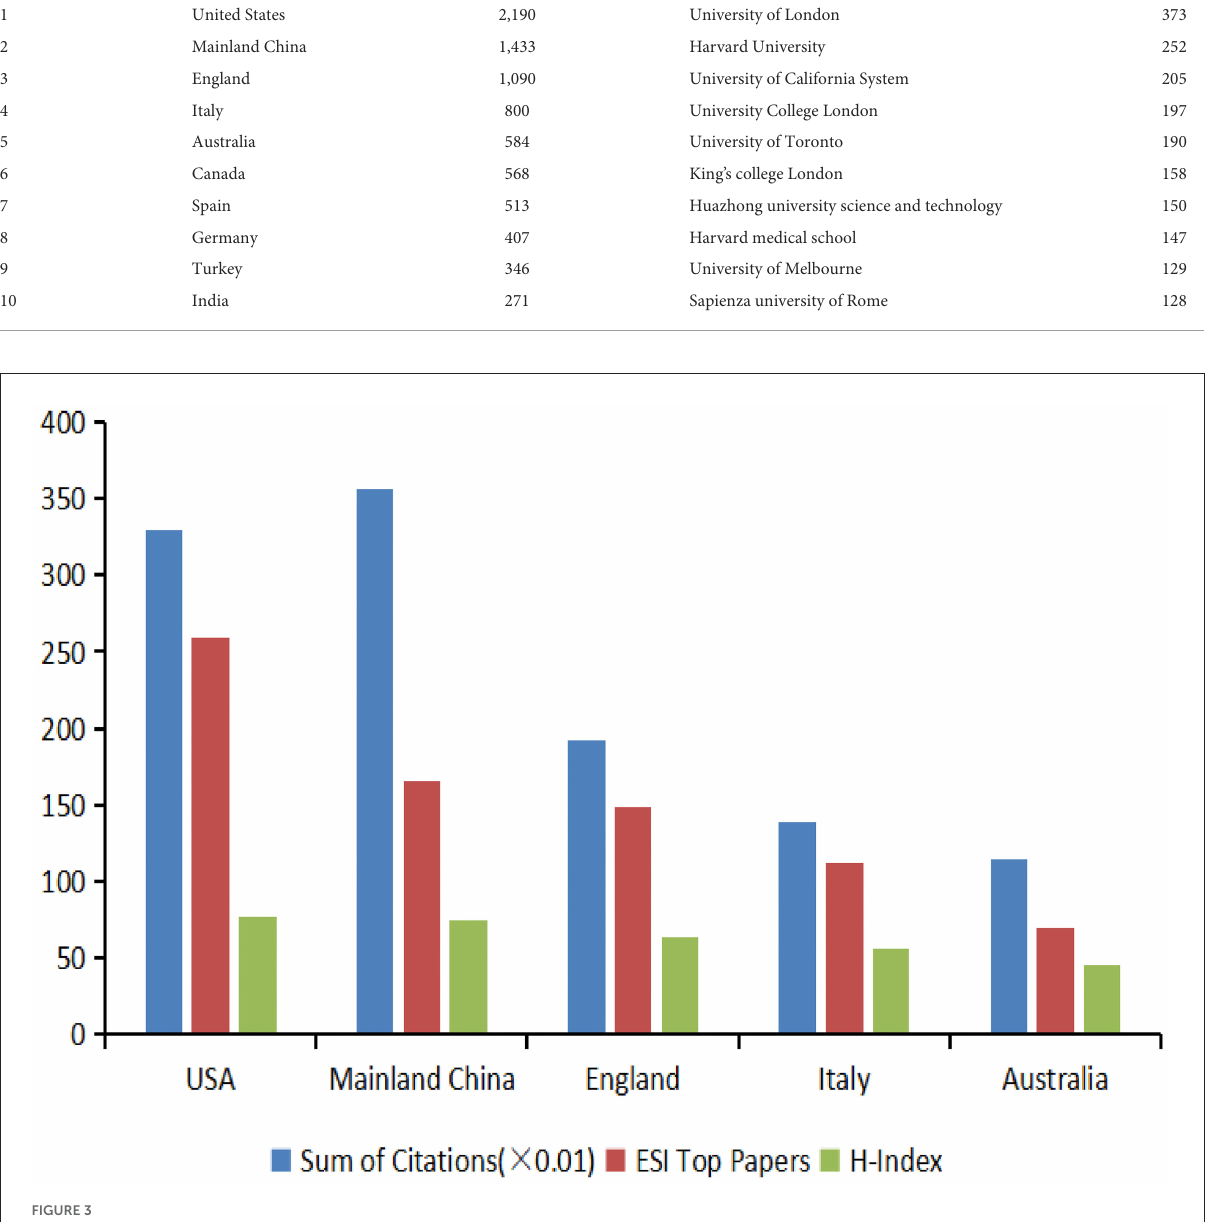
0.01), ESI top papers, and H-index in the top five countries. ×